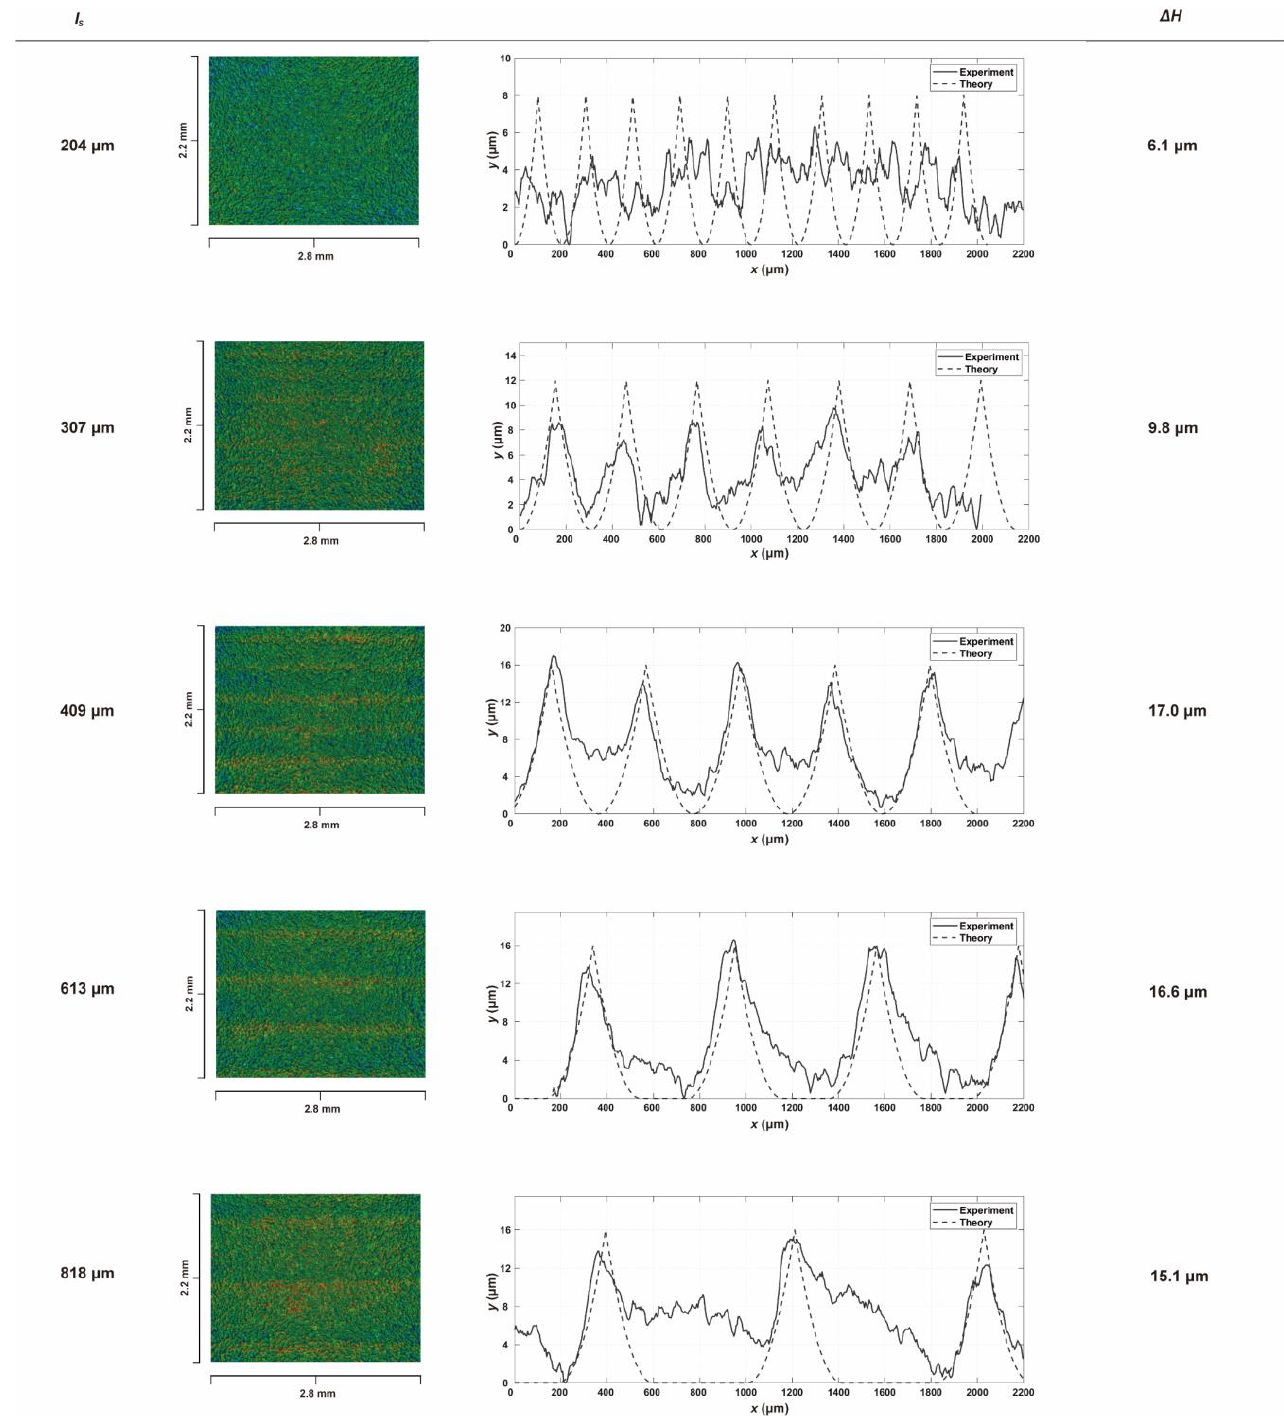
Figure 7. White light interference images and corresponding cross-sectional profiles and maximum height differences Δ H under different l s . The solid line is the cross-sectional profile measured by the experiment, and the dashed line is the cross-sectional profile predicted by the model.